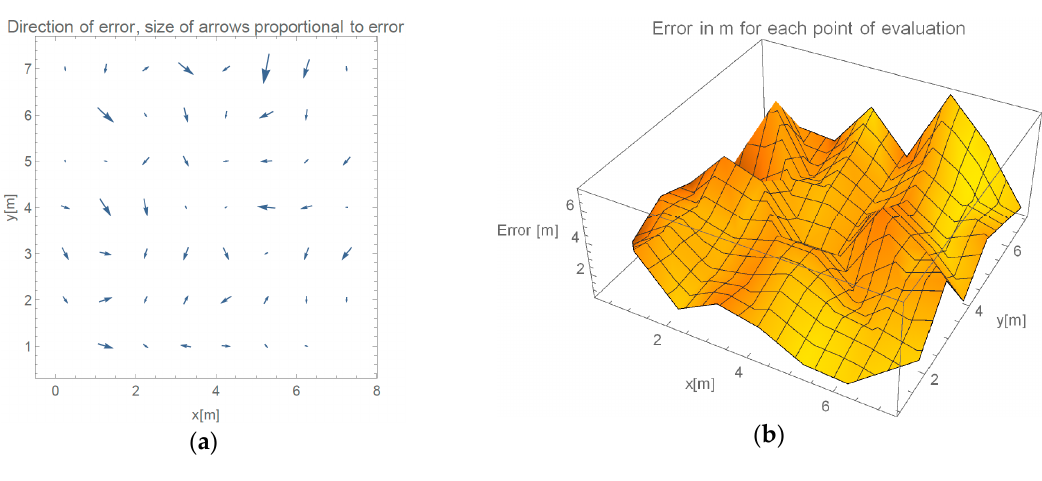
Figure 7. ( a ) Direction of errors in the case of omitting APs on the same wall for calculation of γ ; and ( b ) value of localization error for each reference point, when omitting selected RSSIs.